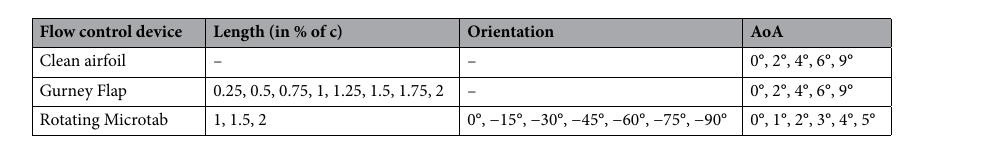
Table 2. Analyzed flow control devices and all their